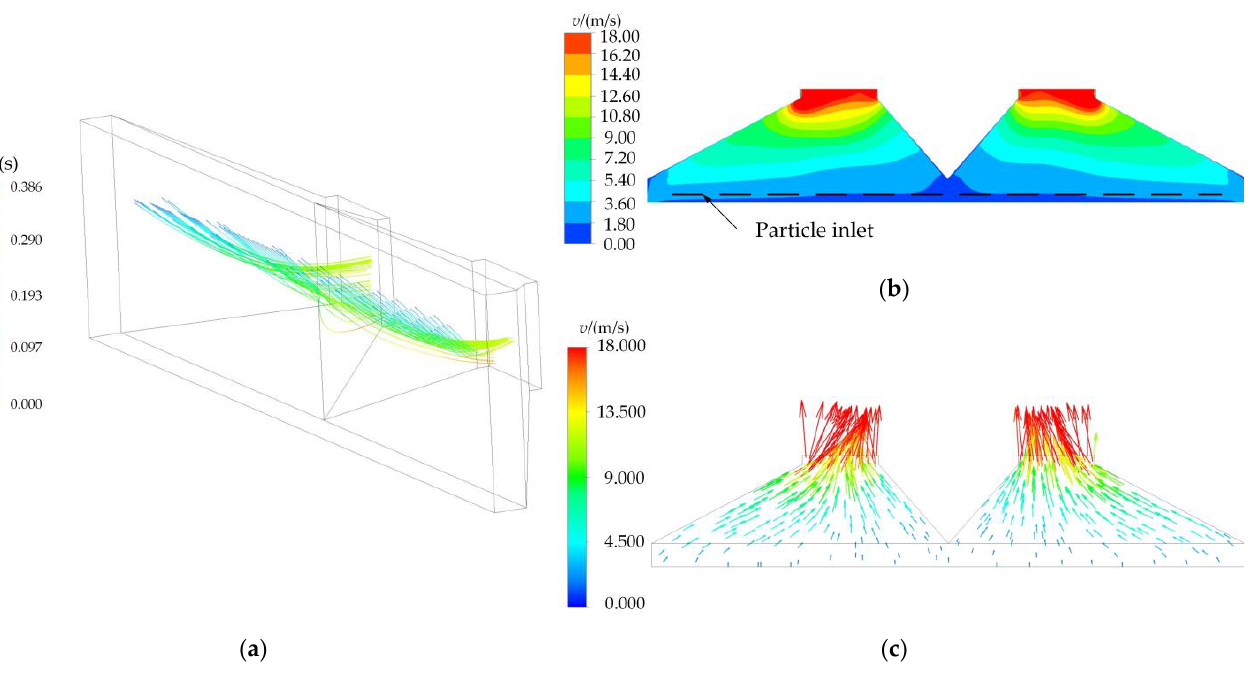
Figure 9. Particle trajectory and airflow velocity distribution (outlet velocity is 18 m/s). ( a ) particle trajectory; ( b ) speed contour; ( c ) velocity vector.